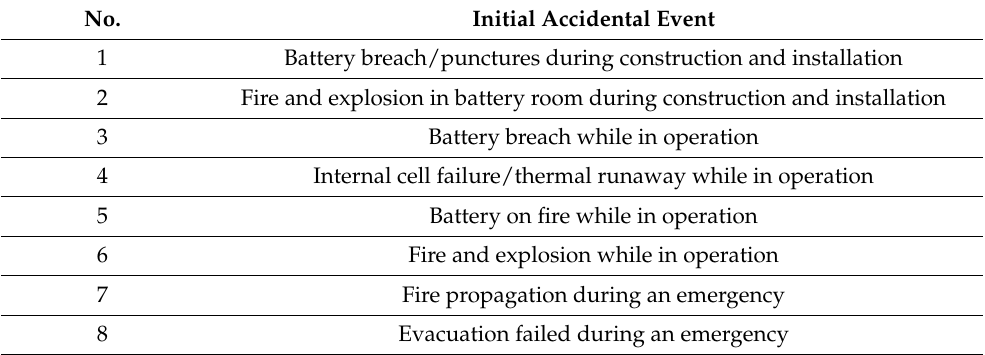
Table 5. The most severe hazards of the battery-powered vessel from